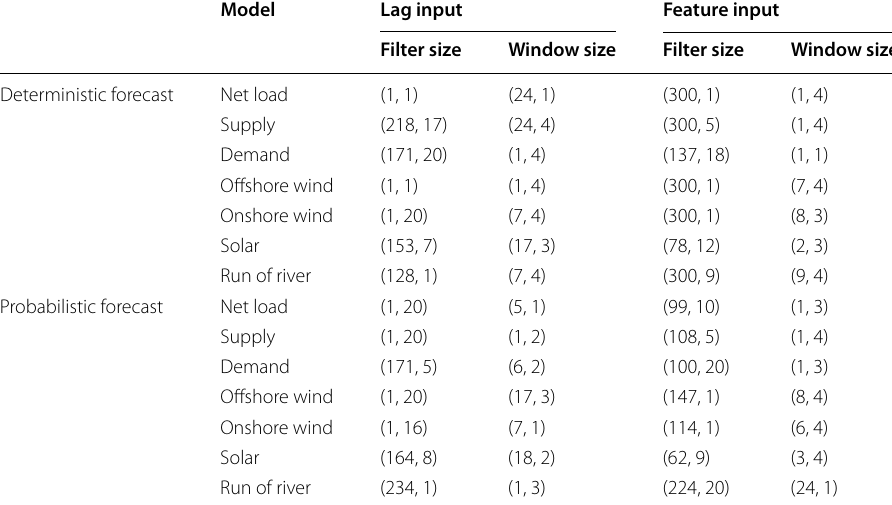
The brackets indicate the layers, i.e. (layer one, layer